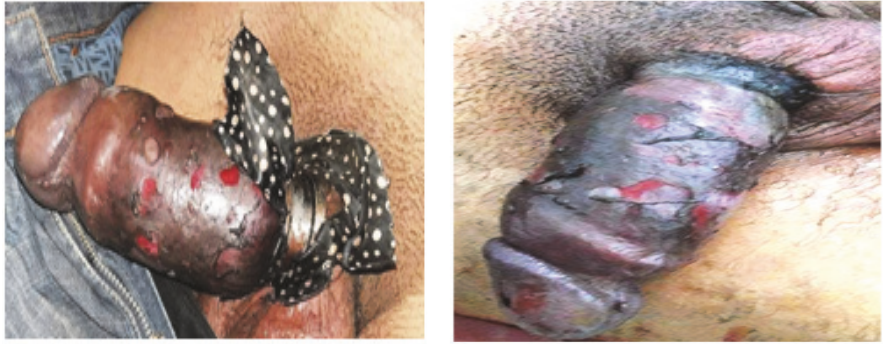
Figure 2: Condition of the penis before and after removing the